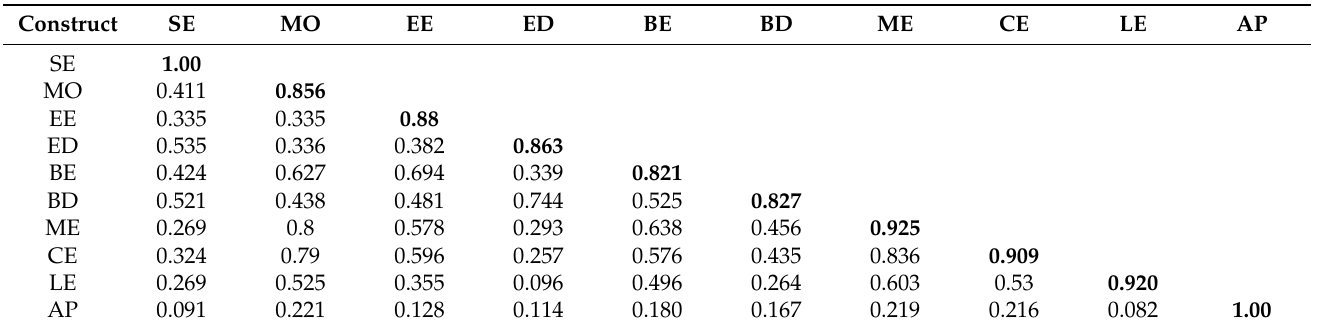
Table 2. Discriminant validity of the constructs of the causal model.